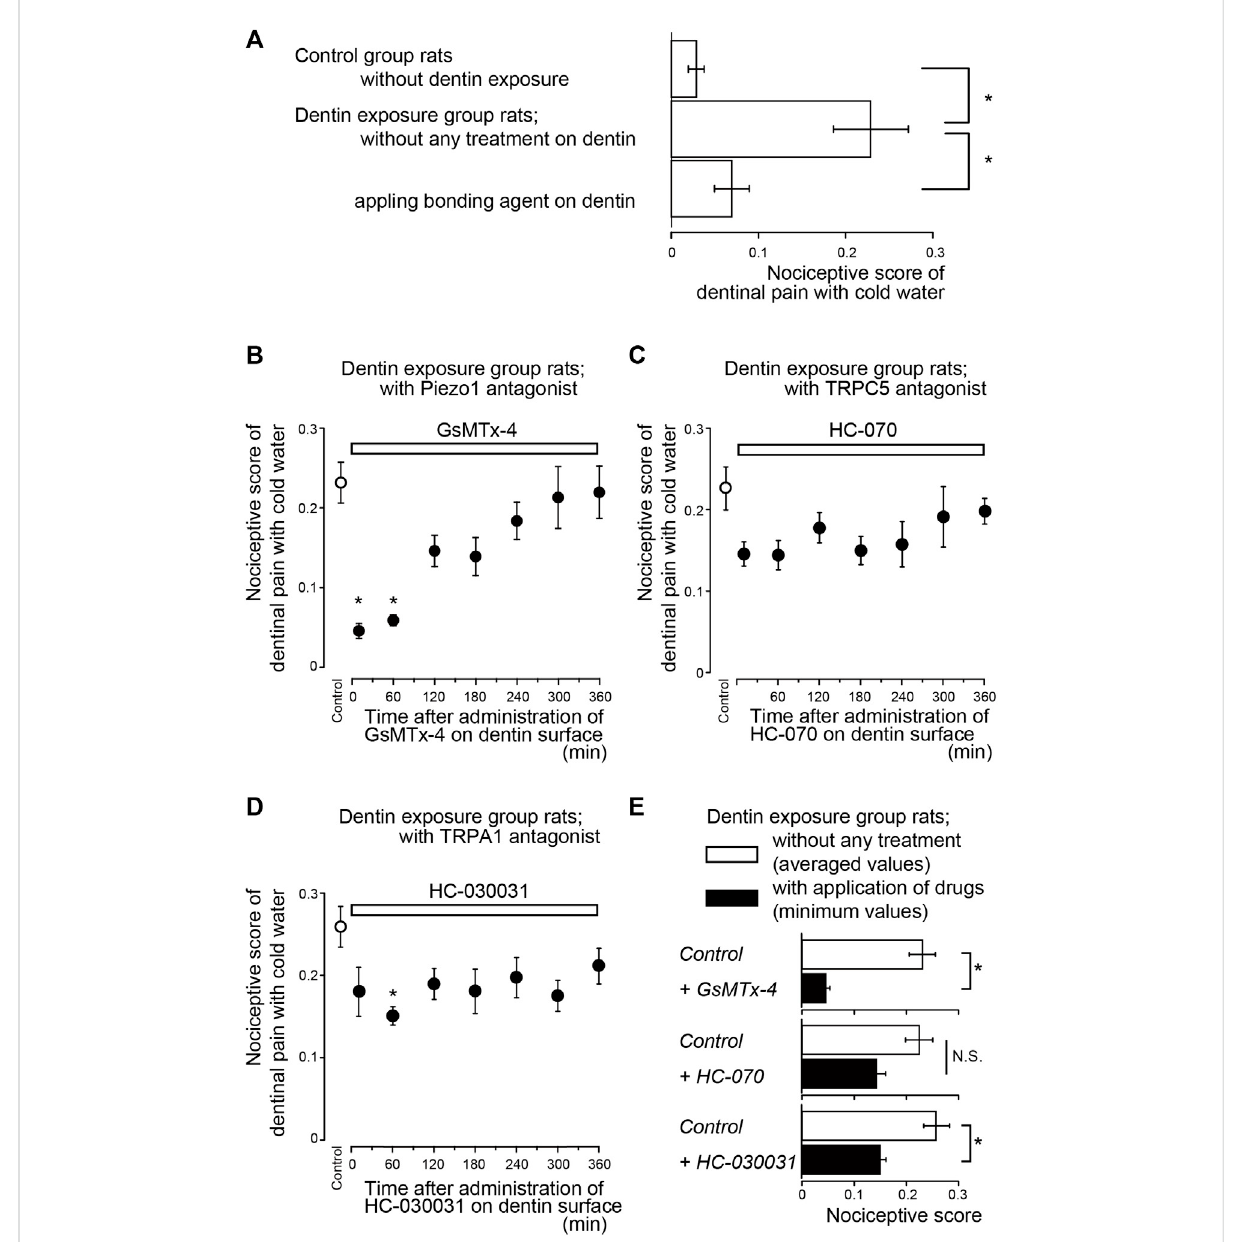
FIGURE 2 Time-dependence of pharmacological effects of Piezo1 (GsMTx-4), TRPC5 (HC-070), and TRPA1 (HC-030031) channel antagonists, as well as bondingagent,ondentinalsensitivity (A) Bargraphshowsvaluesofthenociceptivescoresfollowingcoldwater(0.1 ml,4.0 – 7.0 ° C)stimulationofthe dentinsurfaceinratsinthecontrolgroupinwhichtheenamelsurfacewasetched(uppercolumn, n =8),dentin-exposedratswithoutanytreatment of the dentin surface (middle column, n = 10), and dentin-exposed rats treated with a bonding agent applied to the dentin surface (lower column, n = 8). Each bar denotes the mean ± SE of the number of experiments. Signi fi cant differences between columns (shown by solid lines) are indicated by asterisks: * p < 0.05 (B – D) Time-dependent effects of GsMTx-4 (B; n = 7, 0.8 nmol/g (weight) i.v.), HC-070 (C; n = 8, 0.008 nmol/g (weight), i.v.), and HC-030031 (D; n = 8, 8 nmol/g (weight), i.v.) (upper white boxes) on nociceptive scores following cold water stimulation. Prior to the systemic administration of GsMTx-4, HC-070, or HC-030031 to the dentin-exposed rats, we obtained nociceptive scores as control values (control; white circles). Several minutes after the measurements of the control value in the nociceptive scores, GsMTx-4 (B) , HC-070 (C) , or HC- 030031 (D) were administered to the rats. The cold water stimuli-induced nociceptive scores were measured repeatedly at 10, 60, 120, 180, 240, 300, and 360 min later each (black circles in B to D; see also Materials and Methods). Each point denotes the mean ± SE of the number of experiments. Signi fi cant differences in the scores compared to control values are denoted by asterisks: * p < 0.05. (E) Summary bar graphs showing mean values of nociceptive scores in the dentin-exposed group of rats without any treatment (control; white columns), and their minimum values (during the entire length of administration) in dentin-exposed rats subjected to administration of GsMTx-4 ( n = 7), HC-070 ( n = 8), and HC-030031 ( n =8)(blackcolumns).Eachbarrepresentsmean±SEofthenumberofexperiments.Signi fi cantdifferencesbetweencolumns(shownbysolidlines) are denoted by asterisks: * p < 0.05. N.S.; not signi fi